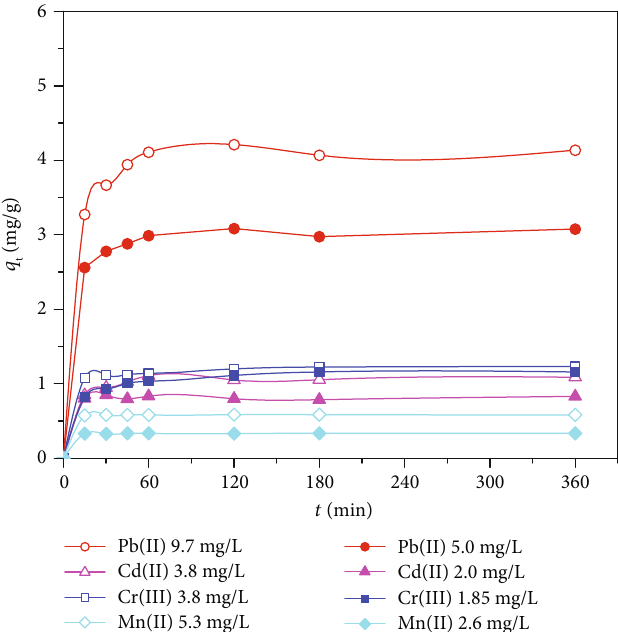
Figure 5: Adsorption capacity versus